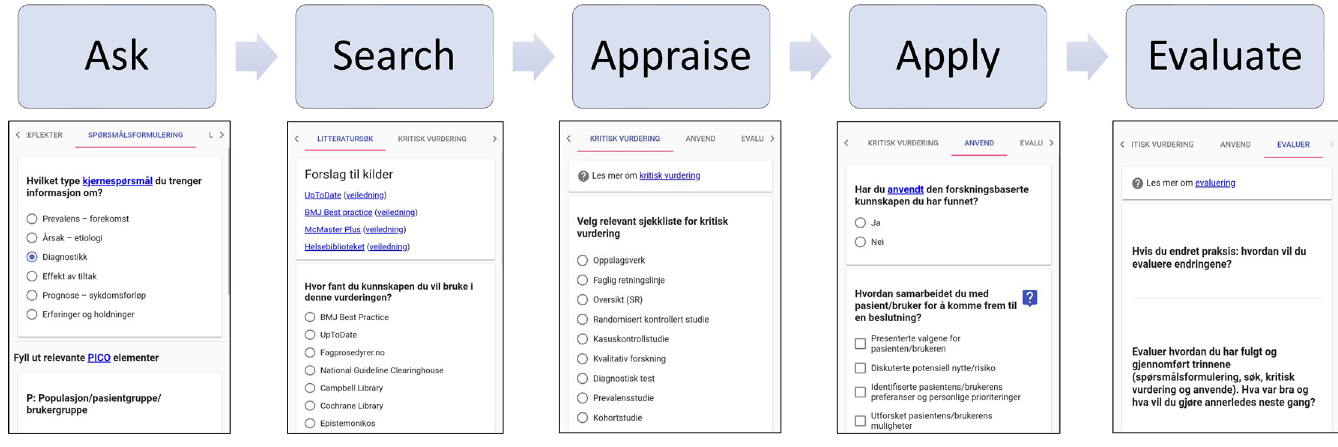
Fig 1. Sample screen of the EBPsteps